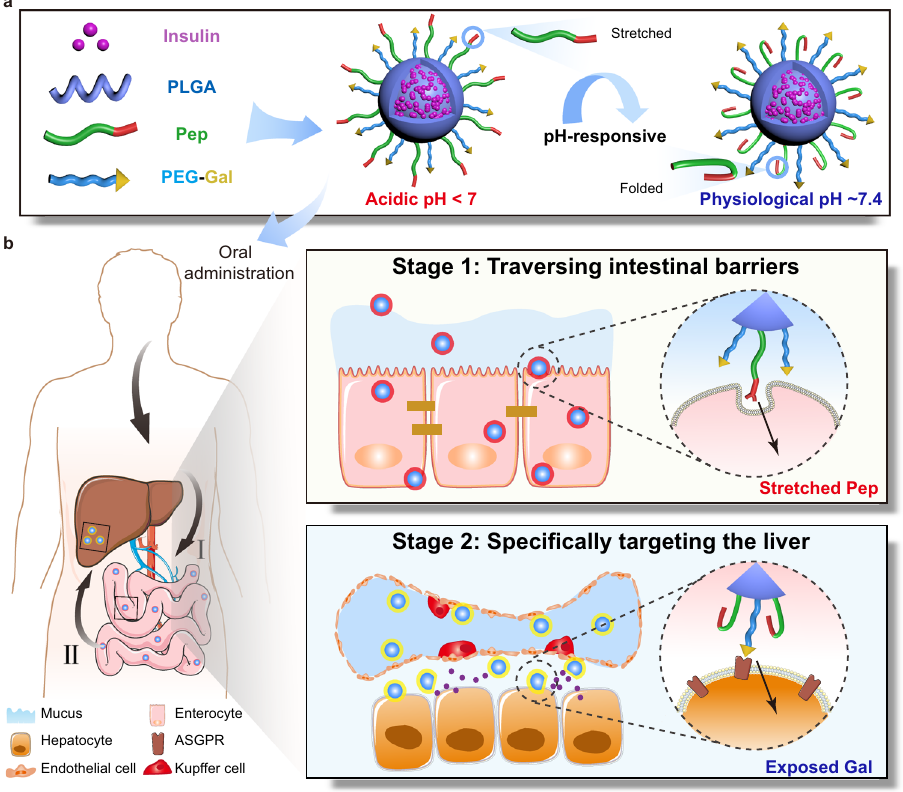
Fig.1|SchematicillustrationsofcompositionandmechanismofPep/Gal-PNPs for oral insulin delivery. a The construction of virus surface-inspired ligand- switchable nanoparticles (Pep/Gal-PNPs) modi fi ed with both a pH-triggered stretchable cell-penetrating peptide (Pep) and a hepatic targeting moiety (galac- tose, Gal). b After oral administration, Pep adopts a stretched conformation in